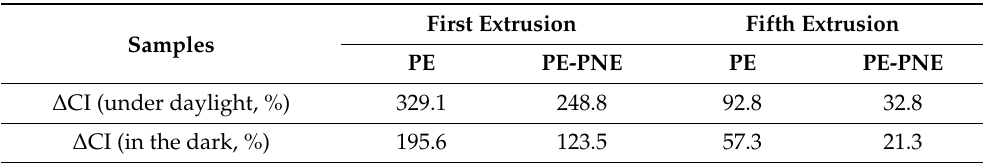
Figure 3. Carbonyl index (CI) of PE-PNE vs. extrusion and storage.